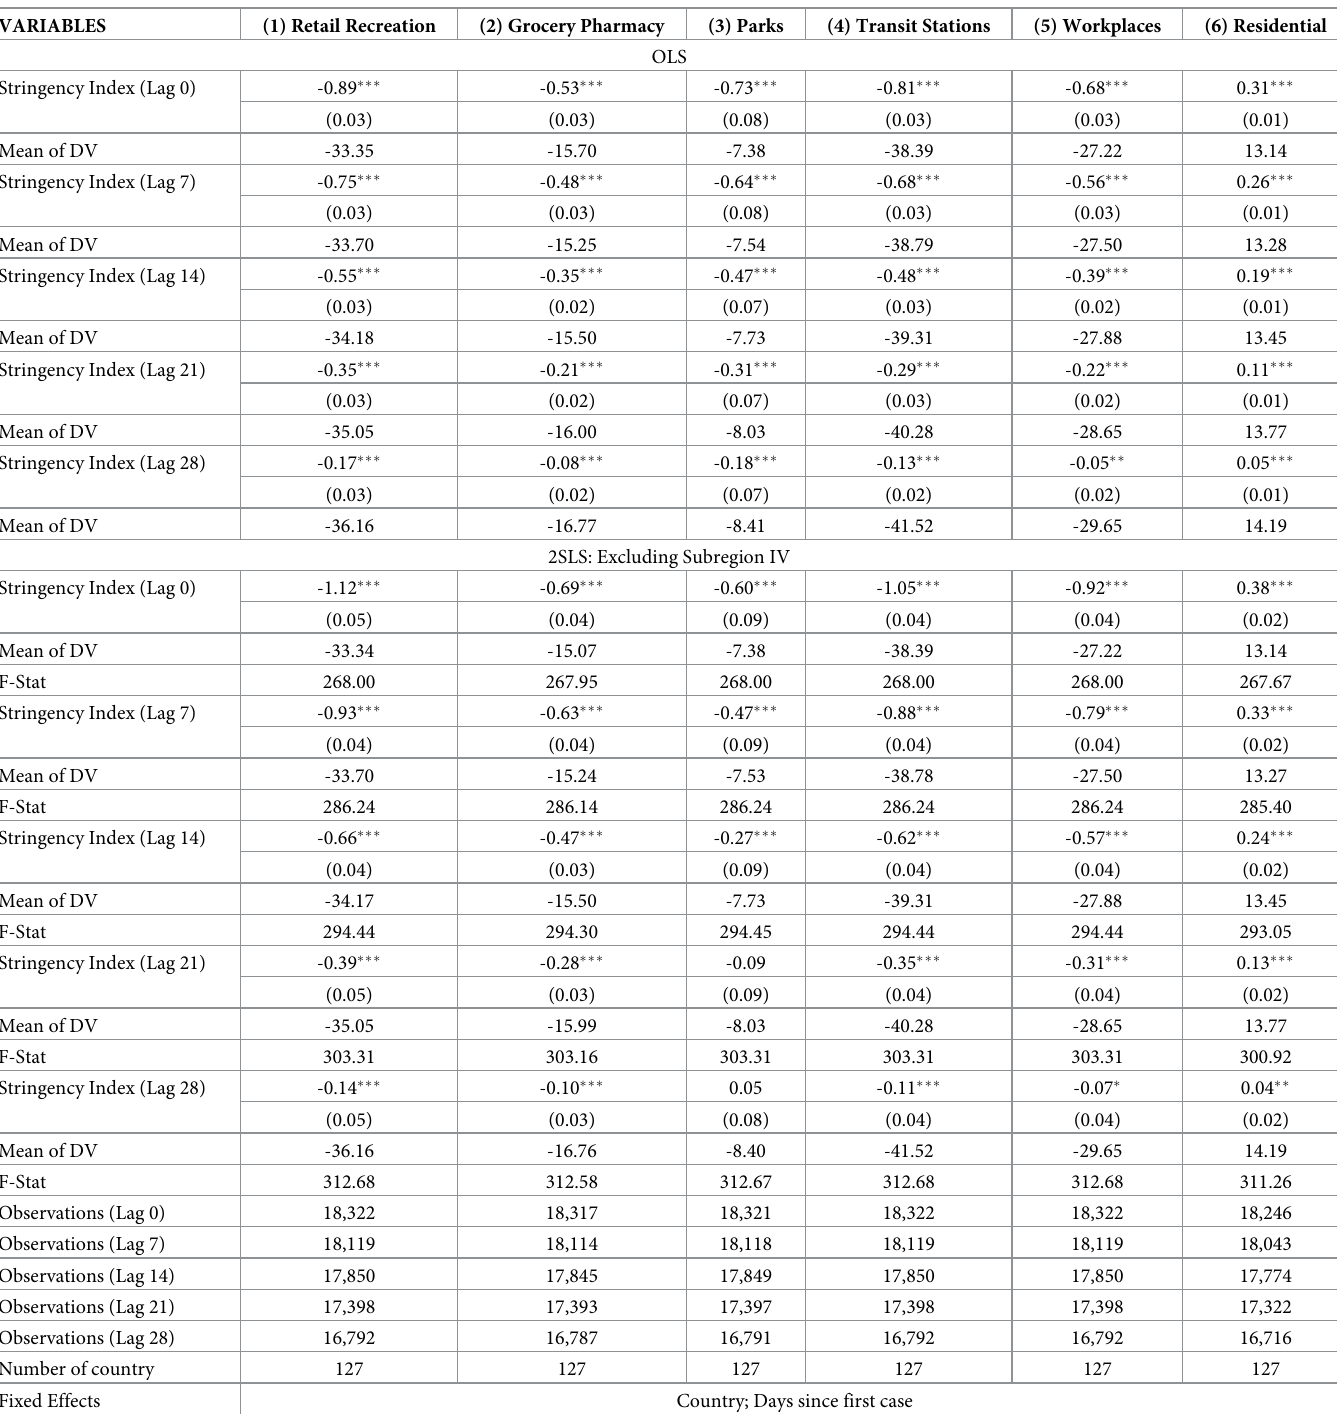
Table 2. Impact of stricter restrictions on